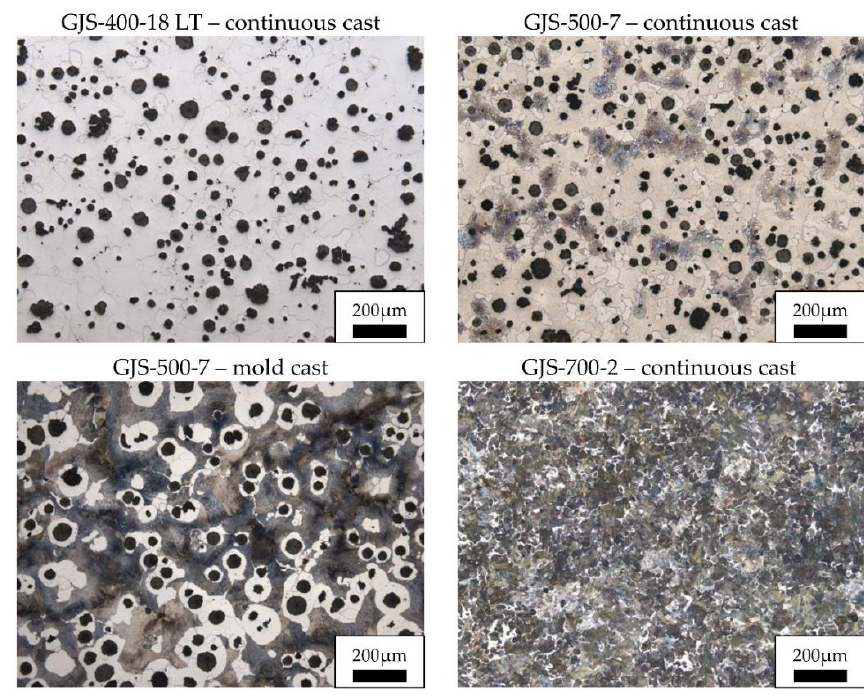
Figure 4. Micrographs of all examined casts, light optical microscopy.